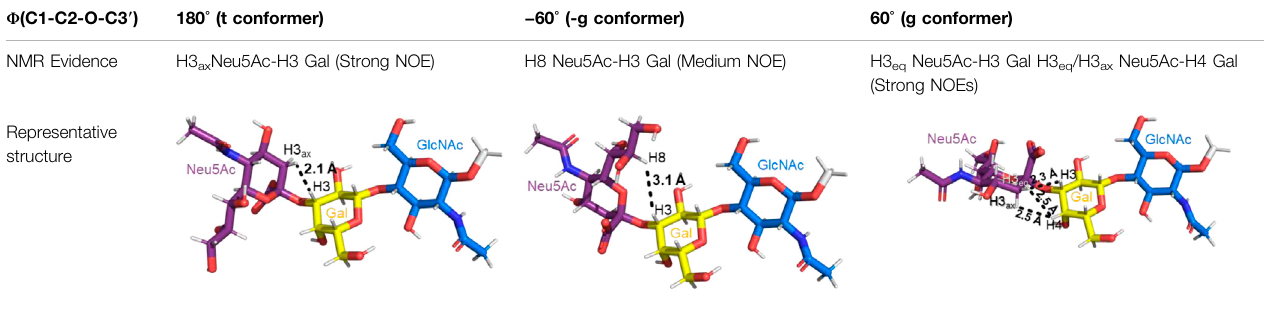
TABLE1| Possibleconformersofan α 2,3-sialoglycaninsolution,representedby3 ′ SLN(Neu5Ac α 2-3Gal β 1-4GlcNAc).Thesethreeconformersdifferinthe φ dihedralangle (C1-C2-O-C3 ′ ), which can adopt values of 180 ° , -60 ° , and 60 ° (t, -g, and g conformers, respectively), whereas the ψ dihedral angle (C2-O-C3 ′ -H3 ′ ) remains stable at around − 11 ° . The t and -g conformers are the most populated in solution. The information about each conformer and the corresponding NMR evidence proving their existence was retrieved from Forgione et al. (2020a) and Forgione et al. (2020b). The representative structures were generated using the carbohydrate builder tool from GLYCAM-web (Woods, 2005), and the images were created using PyMOL 2.4.1 (Schrödinger, 2010). Φ (C1-C2-O-C3 9